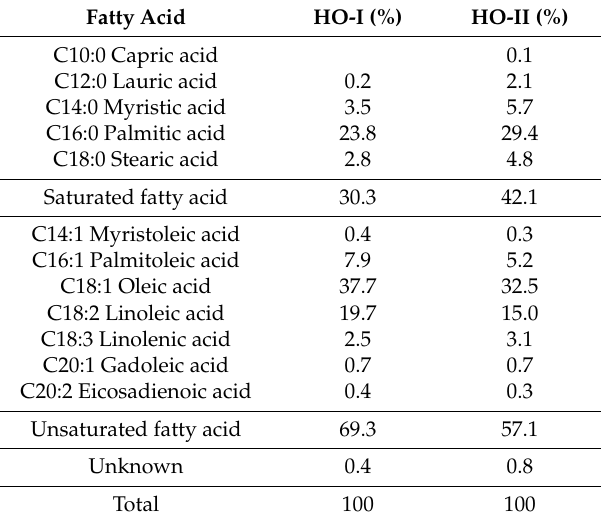
Table 1. Fatty acid contents of horse